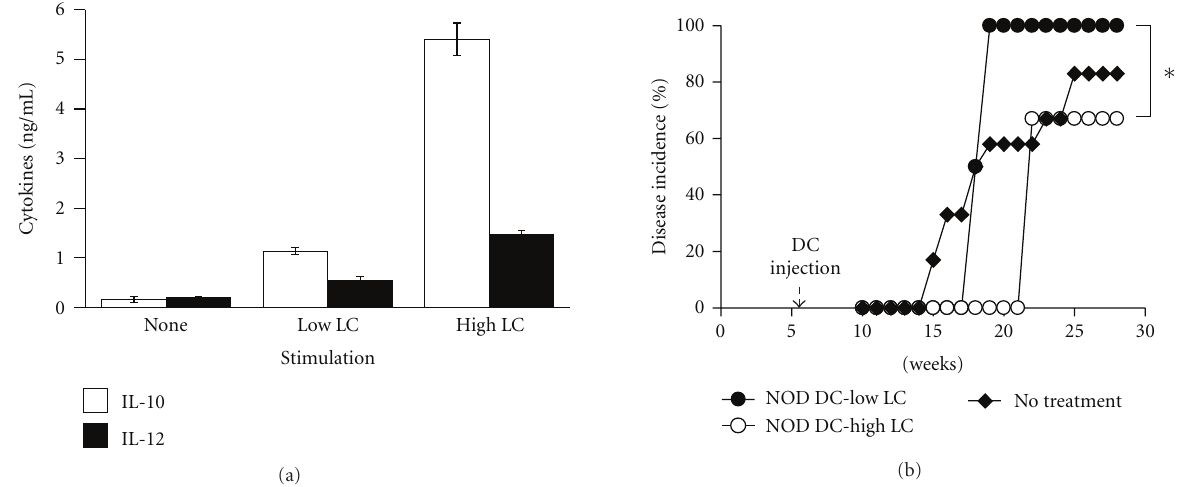
Figure 4: E ff ect of di ff erent doses of L. casei on the profiles of IL-10 and IL-12 production by NOD DCs in vitro and disease incidence. BM-DCs from NOD mice were stimulated with either 1 × 10 6 CFU/mL (Low LC), 20 × 10 6 CFU/mL (High LC) of the L. casei or medium alone (none). After 24hrs, supernatants were collected and measured by ELISA for the presence of IL-10 (white bar) or IL-12 (black bar) (a). Six-week-old NOD mice were left untreated or received a single i.v. injection of 1 × 10 6 DCs treated with either low (1 × 10 6 CFU/mL-low LC) or high (20 × 10 6 CFU/mL-high LC) dose of L. casei (LC) ( n = 4–6) (b). Blood glucose was measured weekly and diabetes incidence determined. ∗ indicates a significant di ff erence at P < .